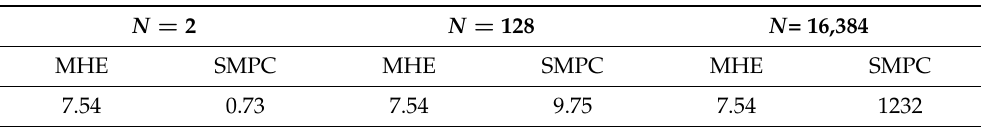
Table 2. Runtime (s) of performing a batch of N divisions where numerators and denominators are randomly chosen from [ 1,1 × 10 4 ] . N = 2 N = 128 N = 16,384